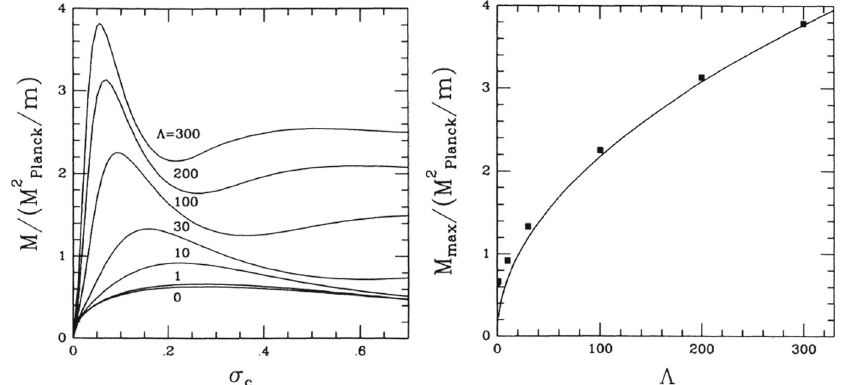
Fig. 3 Left: The mass of the boson star as a function of the central value of the scalar field in adimensional √ 4 π G φ c . Right: Maximum mass as a function of Λ (squares) and the asymptotic Λ → ∞ units σ c = relation of Eq. (52) (solid curve). Reprinted with permission from Colpi et al. (1986); copyright by